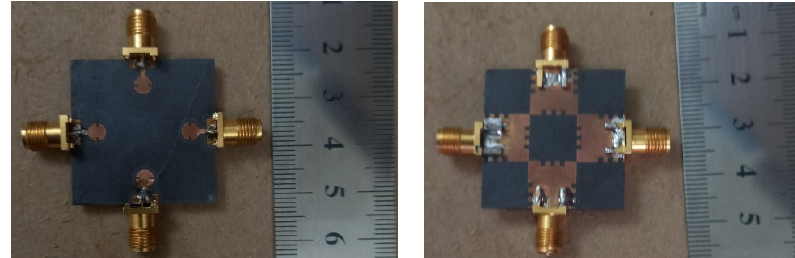
Figure 8. Prototype of proposed MIMO Antenna for 28 GHz 5G applications.